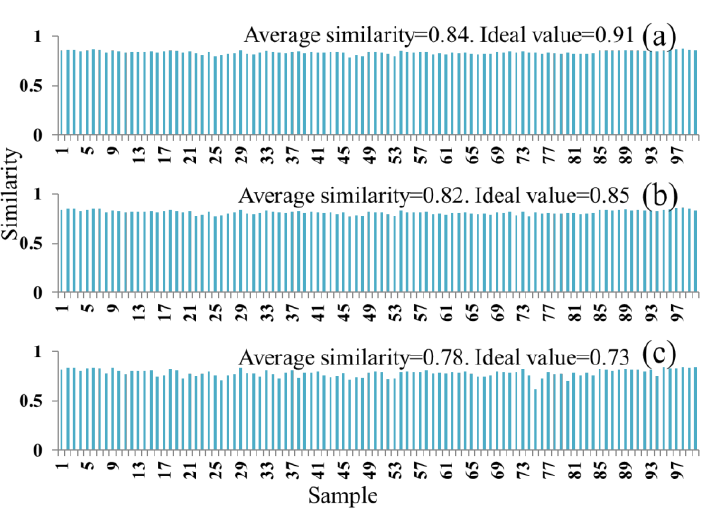
Figure 9. The registration similarity of the rotation images. ( a ) Rotation angle = − 5; ( b ) rotation angle = − 15; and ( c ) rotation angle = − 25.